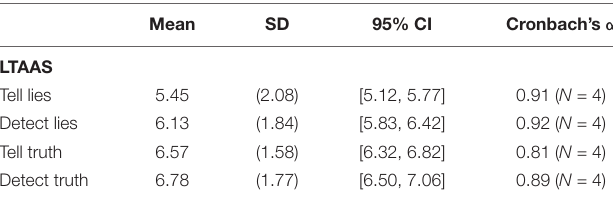
TABLE 4 | Means (and SDs), confidence intervals, and reliability scores separated for the four self-assessed